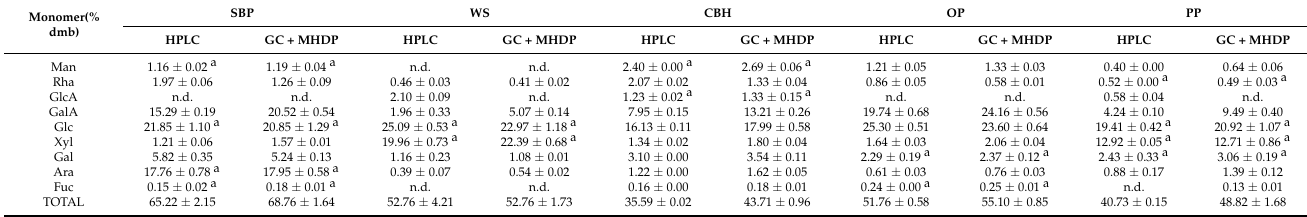
Table 4. Monomeric profile of selected agro-industrial wastes determined using the developed HPLC- DAD method and GC (alditol acetate) method in combination with the colorimetric (MHDP)